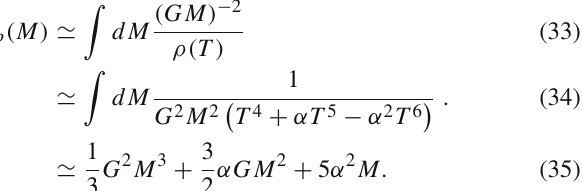
the black hole complementarity has to be restated or to be abandoned as a resolution to Information Loss